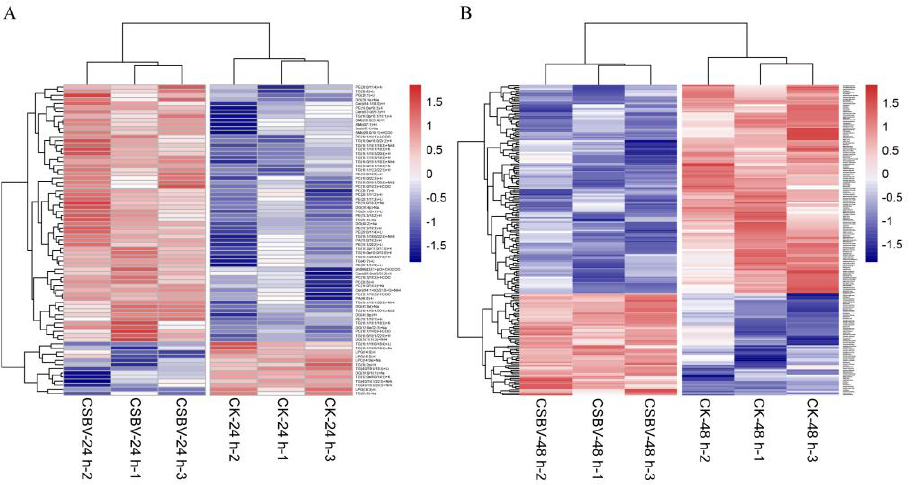
Figure 4. Global lipidome profile of CSBV-infected versus uninfected A. c. cerana larvae. ( A ) Heatmap showing the lipidomic analysis of CSBV_24 h vs. CK_24 h; ( B ) heatmap showing the lipidome analysis of CSBV_48 h vs. CK_48 h.